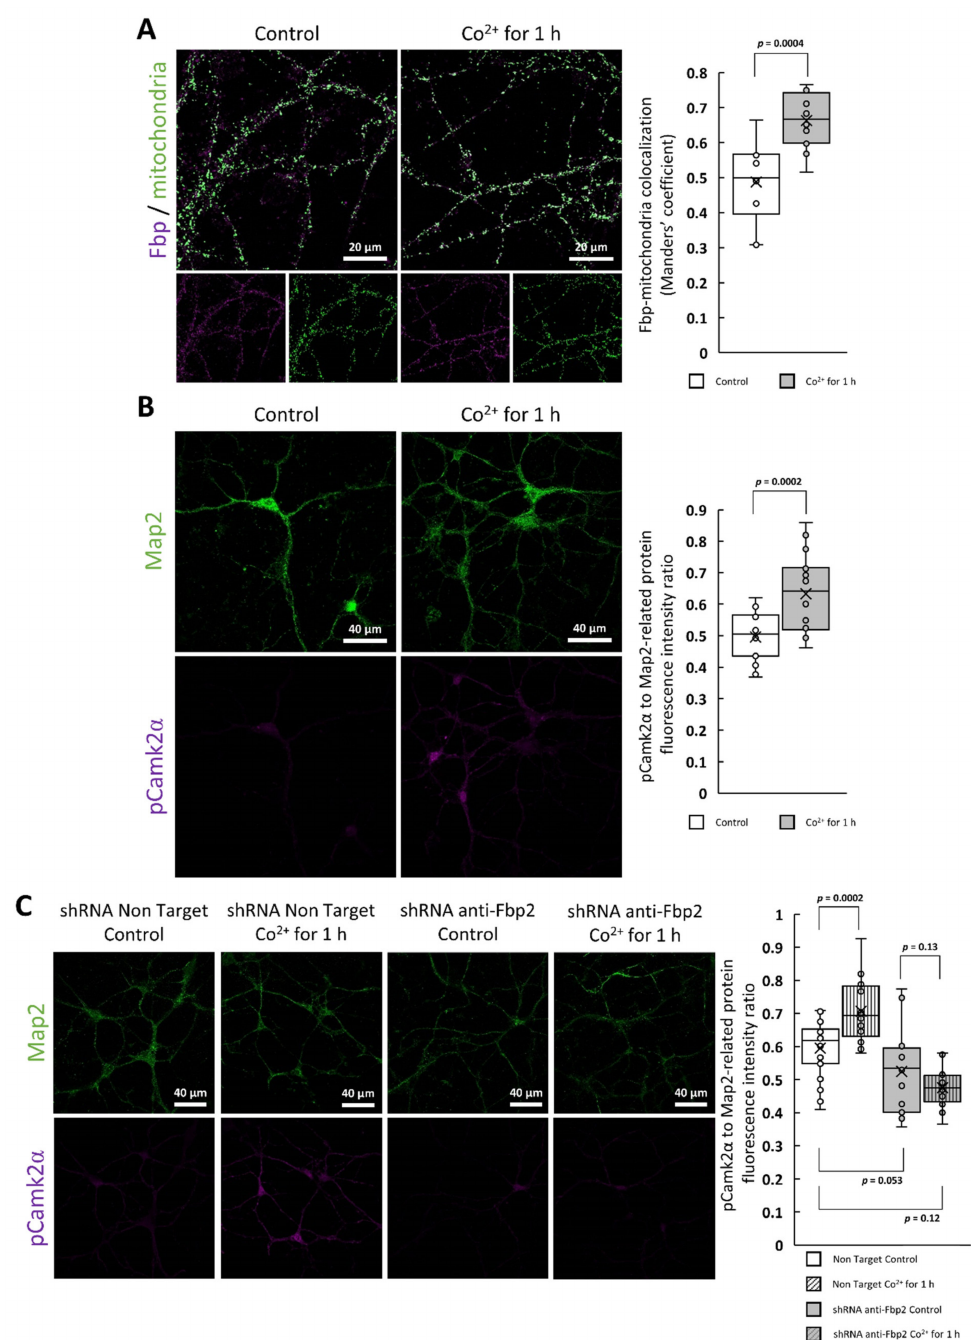
Figure 7. The effect of short-term Co 2+ -treatment of neurons. Incubation of neurons with Co 2+ for 1 h resulted in ( A ) the increased Fbp-mitochondria colocalization and ( B ) elevated amount of detected pThr286 Camk2 α . ( C ) The increased pThr286 Camk2 α level after acute Co 2+ treatment is not observed in neurons with partially silenced Fbp2